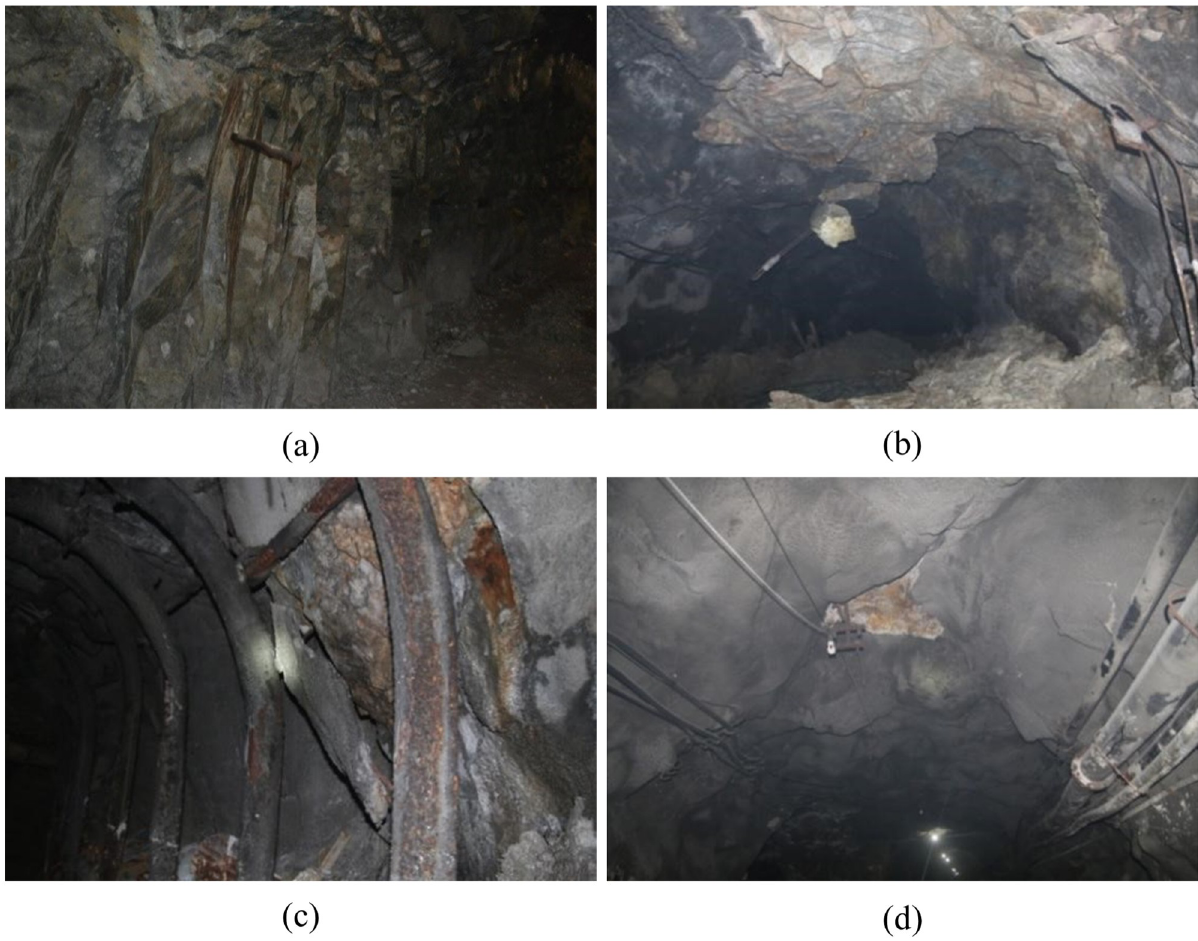
Fig 16. Stope failure in four-layer (a) Bolt support failure; (b) Roof Caving; (c) Cracking of side concrete; (d) Roof concrete caving.